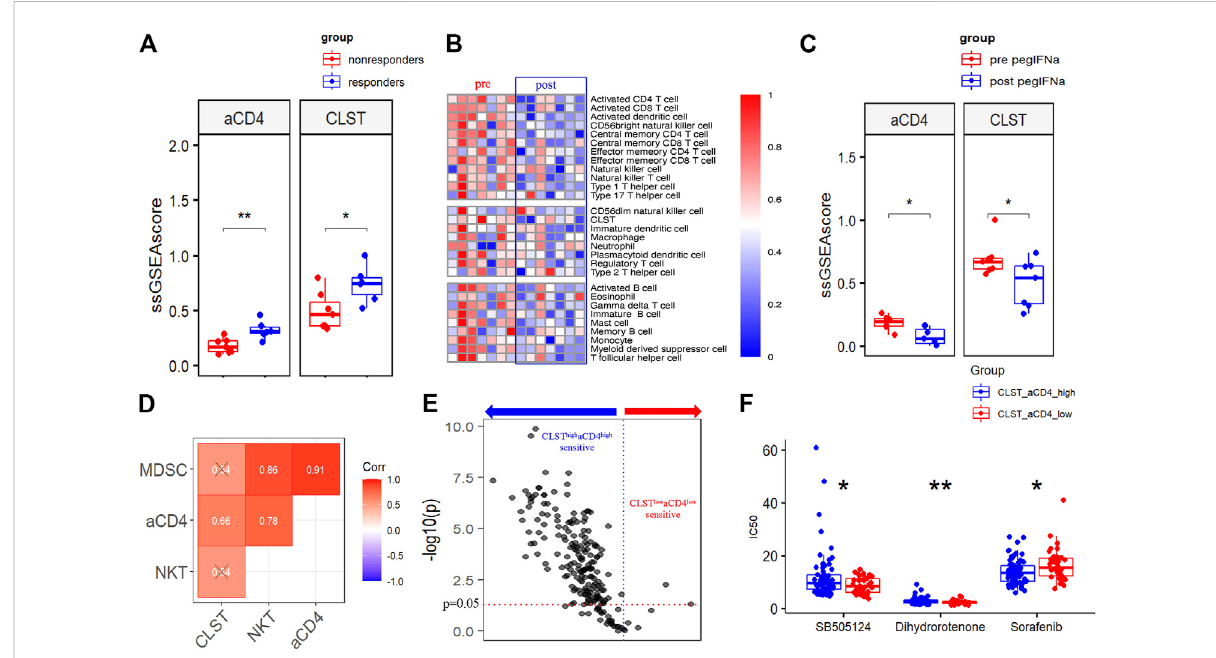
FIGURE 8 CLST and aCD4 were involved in drug sensitivity to anti-HBV immunotherapy and anti-cancer chemotherapies. (A) Comparisons of CLST and aCD4 between PEG IFN- α treatment responders and non-responders (GSE27555). (B) Heatmaps showing differences in liver samples from HBV- infected patients pre and post PEG-IFN- α treatment (GSE66698). (C) Boxplot of pairwise comparisons of CLST, aCD4, NKT, and MDSC between the control group and PEG IFN- α -treated group (GSE66698). (D) Correlations among CLST, aCD4, NKT, and MDSC in PEG IFN- α -treated liver samples (GSE66698). (E) Volcano plot of the sensitivity of HBV-HCC patients in the CLST high aCD4 high subgroup and CLST low aCD4 low subgroup to 198 anti-cancer drugs. (F) Comparisons of the sensitivity to fi rst-line chemotherapy (sorafenib) and emerging chemotherapies (SB505124, dihydrorotenone) between the CLST high aCD4 high subgroup and CLST low aCD4 low subgroup